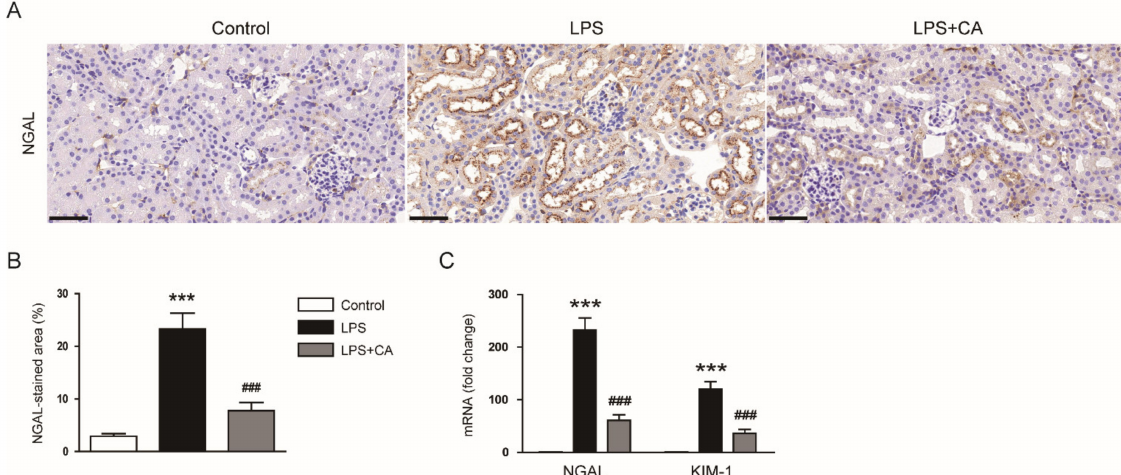
Figure 2. Effect of carnosic acid on tubular injury markers. ( A ) IHC staining for NGAL on kidney sections. Scale bar: 50 µ m. ( B ) Percentage of NGAL-stained area. ( C ) The mRNA expression of NGAL and KIM-1 in kidney tissues. n = 8 per group. *** p < 0.001 versus control. ### p < 0.001 versus LPS.